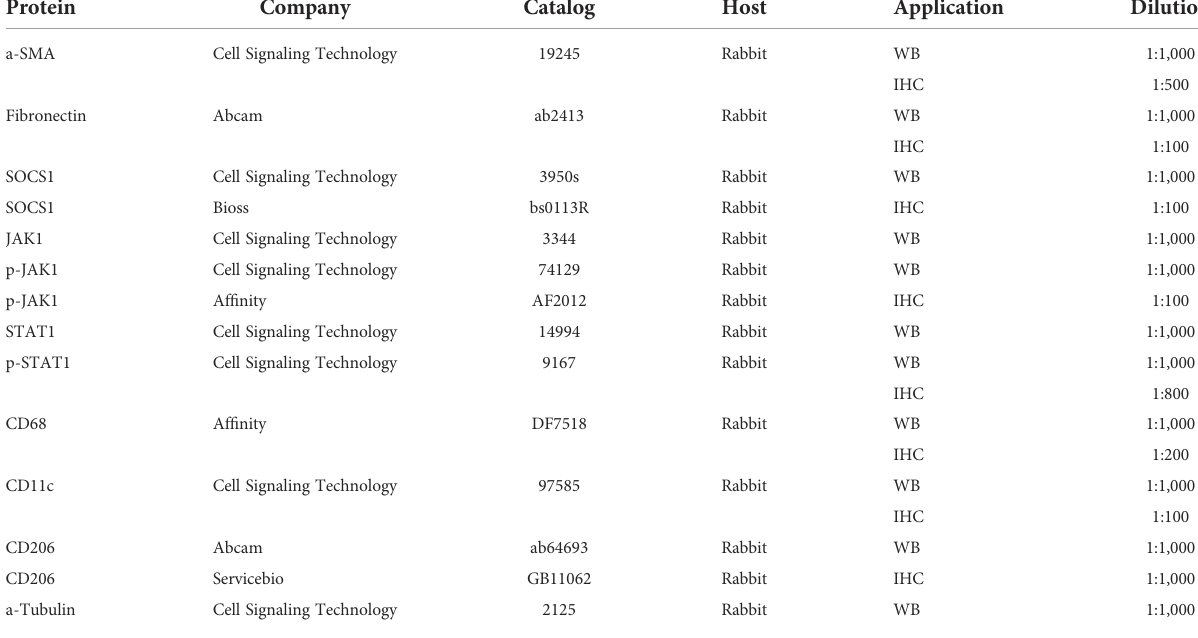
TABLE 1 Antibodies used in Western blotting and immunohistochemistry. Protein